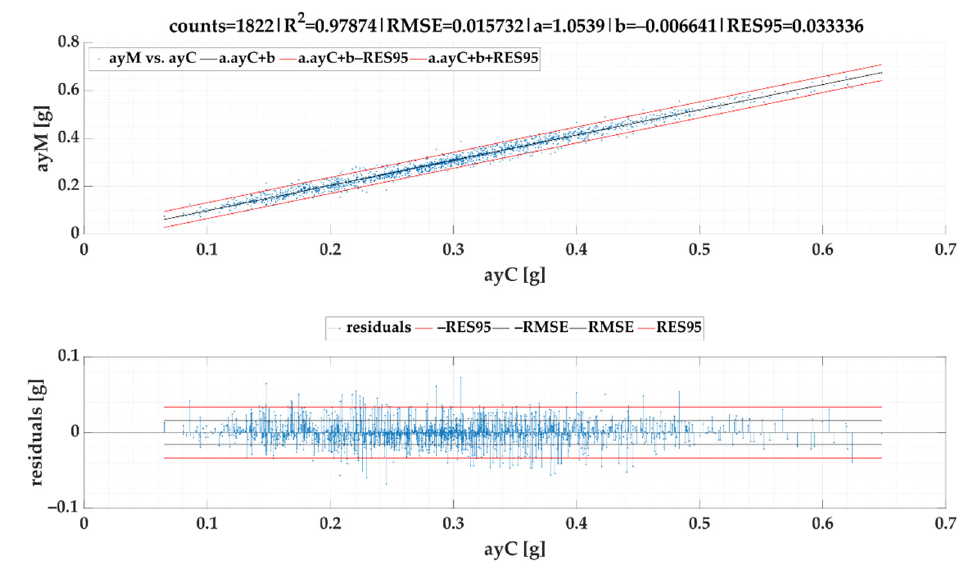
Figure 12. Calculated 𝑎𝑦𝐶 vs. measured 𝑎𝑦𝑀 of events for SEL2.